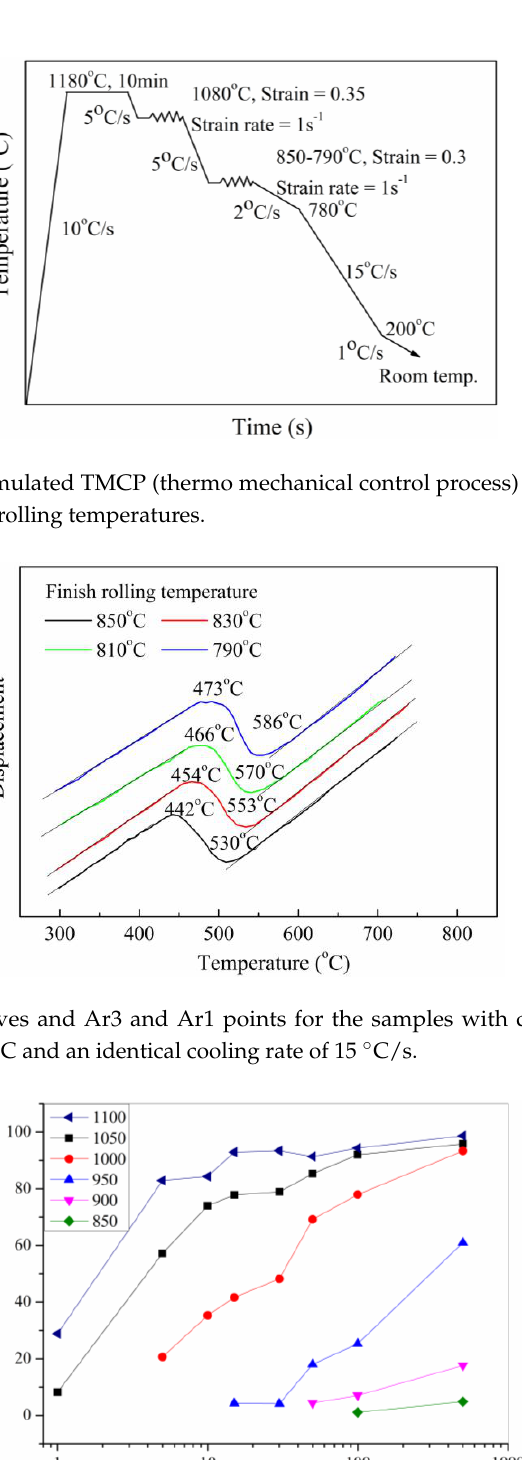
Figure 3. The fractions of recrystallized grains as functions of a varying finish rolling temperature and interval time between two passes.